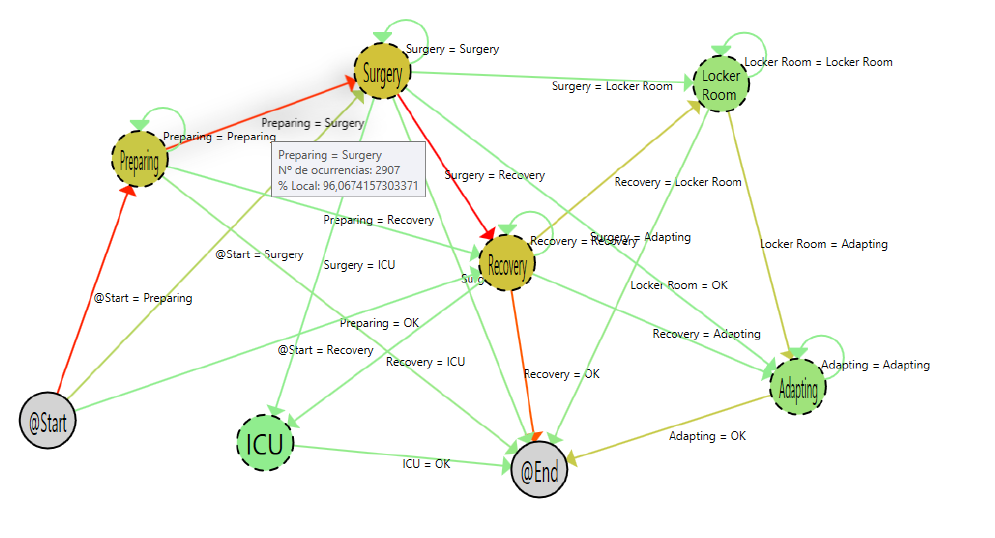
Figure 6. Detail of the tool tip.